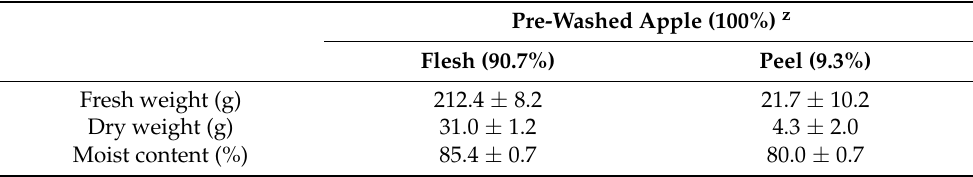
Figure 1. Antioxidant activities and compounds in different antioxidant assays comparing whole apple (peel + flesh) and flesh. NS, asterisk **, and asterisk *** indicate non-significant and significant differences between the peel and the flesh within the same assay, assessed by Student t -test at p > 0.05, p < 0.01, and p < 0.001, respectively. ( A ): Ferric-reducing antioxidant power; ( B ): DPPH radical scavenging activity; ( C ): total flavonoid contents; ( D ): total phenolic contents. Table 1. Morphological characteristics of ‘Fuji’ pre-washed apple ( Malus pumila